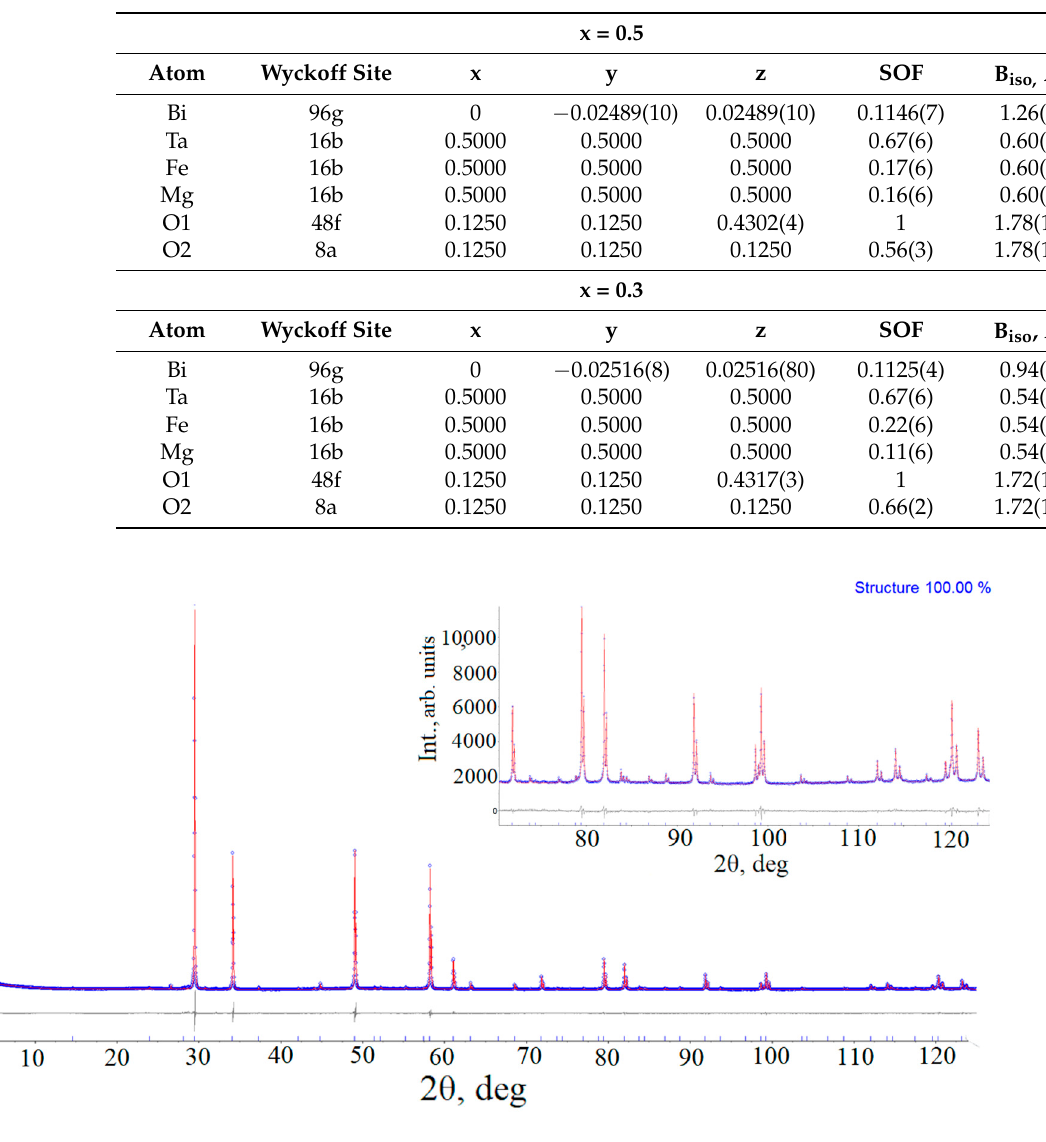
Table 1. Parameters of atoms in the Bi 2 Mg x Fe 1 − x Ta 2 O 9.5 − ∆ (x = 0.5; 0.3).